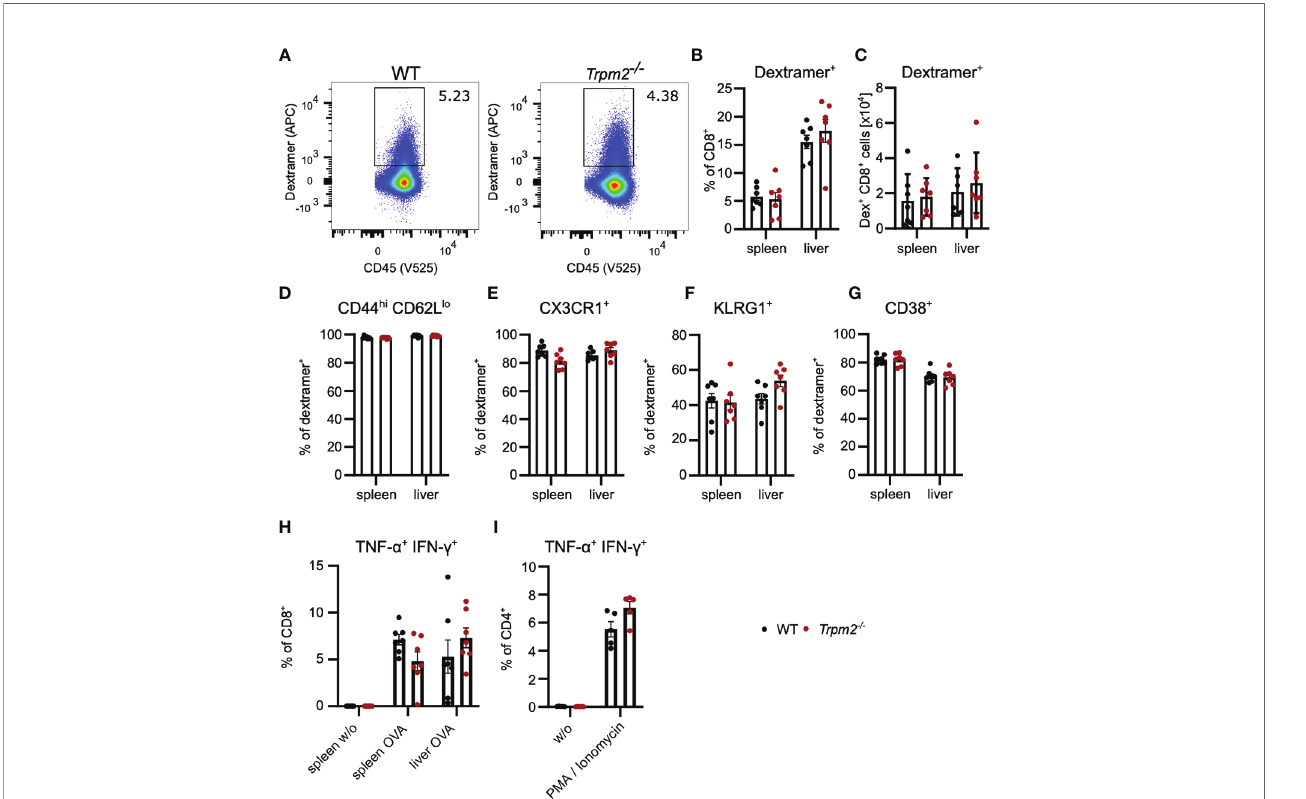
FIGURE 3 | TRPM2 de fi ciency does not impair the CD8 + T-cell response to L. monocytogenes. Trpm2 -/- and WT mice were infected with LmOVA. Mice were treated with ampicillin in the drinking water from day 2 on until analysis at day 8. Ovalbumin-speci fi c CD8 + T cells were detected with H − 2K b OVA 257-264 -dextramers. (A) Representative dextramers staining of CD8-gated T cells. (B) Frequencies and (C) numbers of dextramers + CD8 + T cells in spleen and liver of infected mice. (D – G) Percentage of CD44 hi CD62L lo (D) , CX3CR1 + (E) , KLRG1 + (F) , and CD38 + (G) cells among dextramer + CD8 + T cells. (H) Spleen and liver cells were stimulated for 4 h with OVA 257-264 peptide and the expression of IFN- g and TNF- a in CD8 + T cells was determined by intracellular cytokine staining. (I) Spleen cells were stimulated for 4 h with PMA/ionomycin, and the expression of IFN- g and TNF- a in CD4 + T cells was determined by intracellular cytokine staining. Bars in (C – I) give the mean ± SEM and were analyzed with the unpaired t-test. Data from one of three experiments are